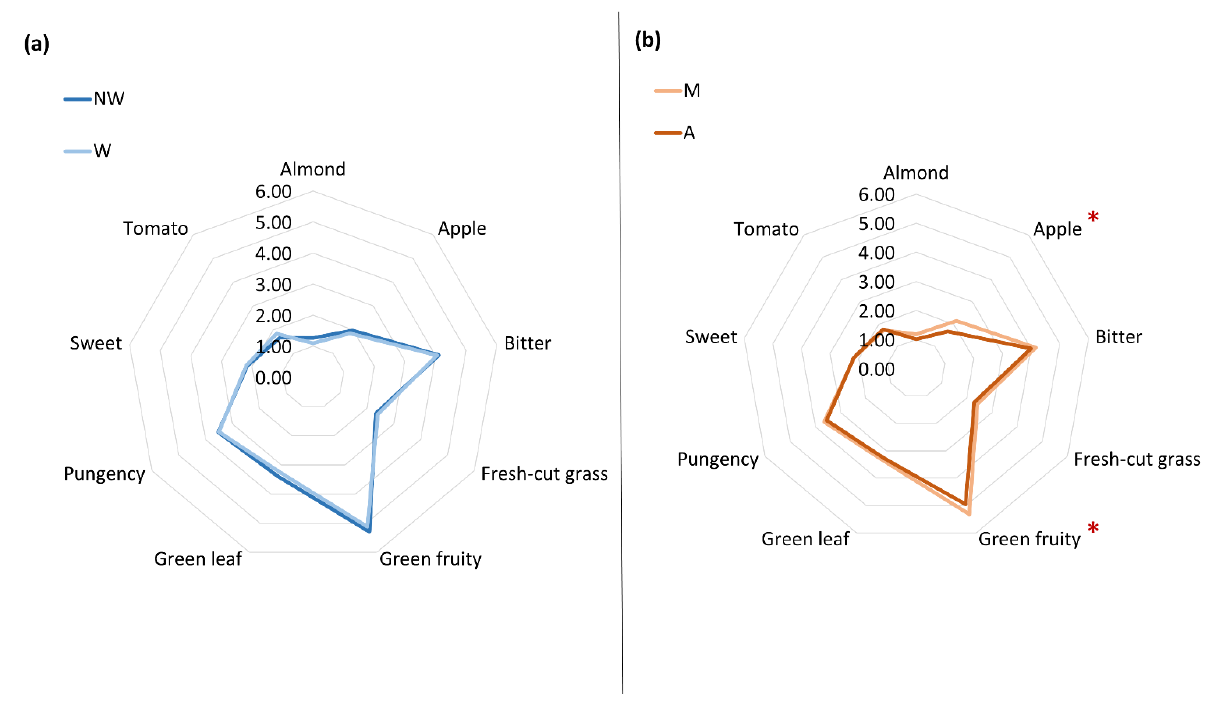
Figure 2. Comparison of the sensory profiles (odor attributes) between the Organic Extra Virgin Olive Oil (OEVOOs) obtained from washed (W) and non-washed fruits (NW) ( a ) and from fruits harvested during morning (M) or afternoon (A) ( b ). * Significant differences (Tukey’s test).